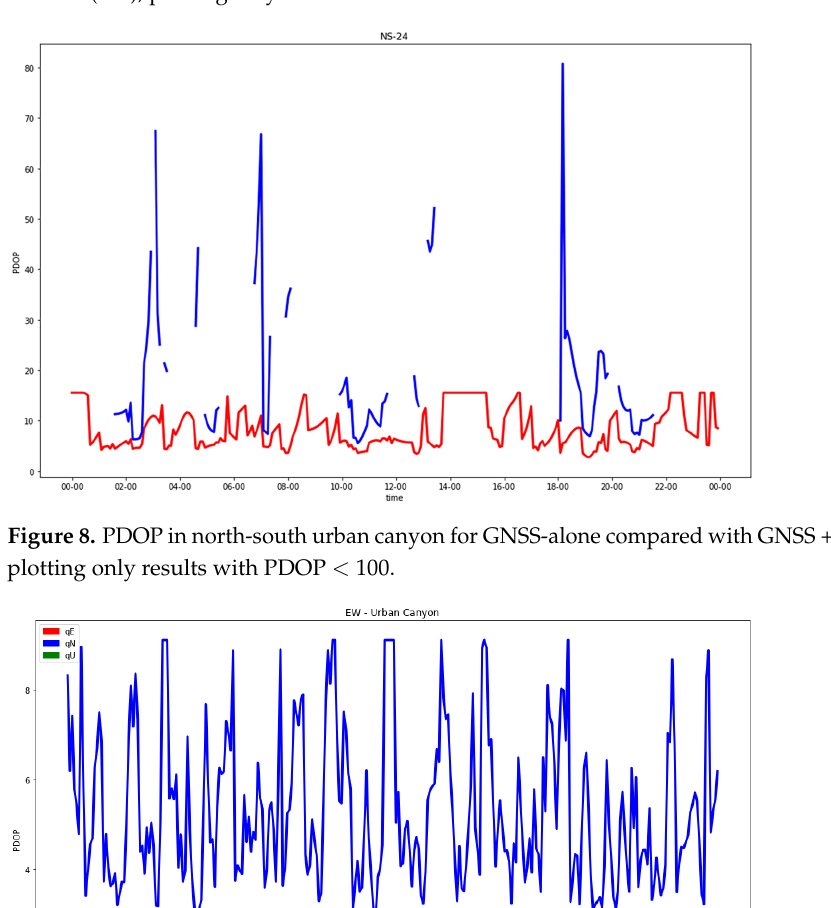
Figure 7. PDOP in east-west urban canyon for GNSS-alone (blue) compared with GNSS + five 5G stations (red), plotting only results with PDOP < 100.